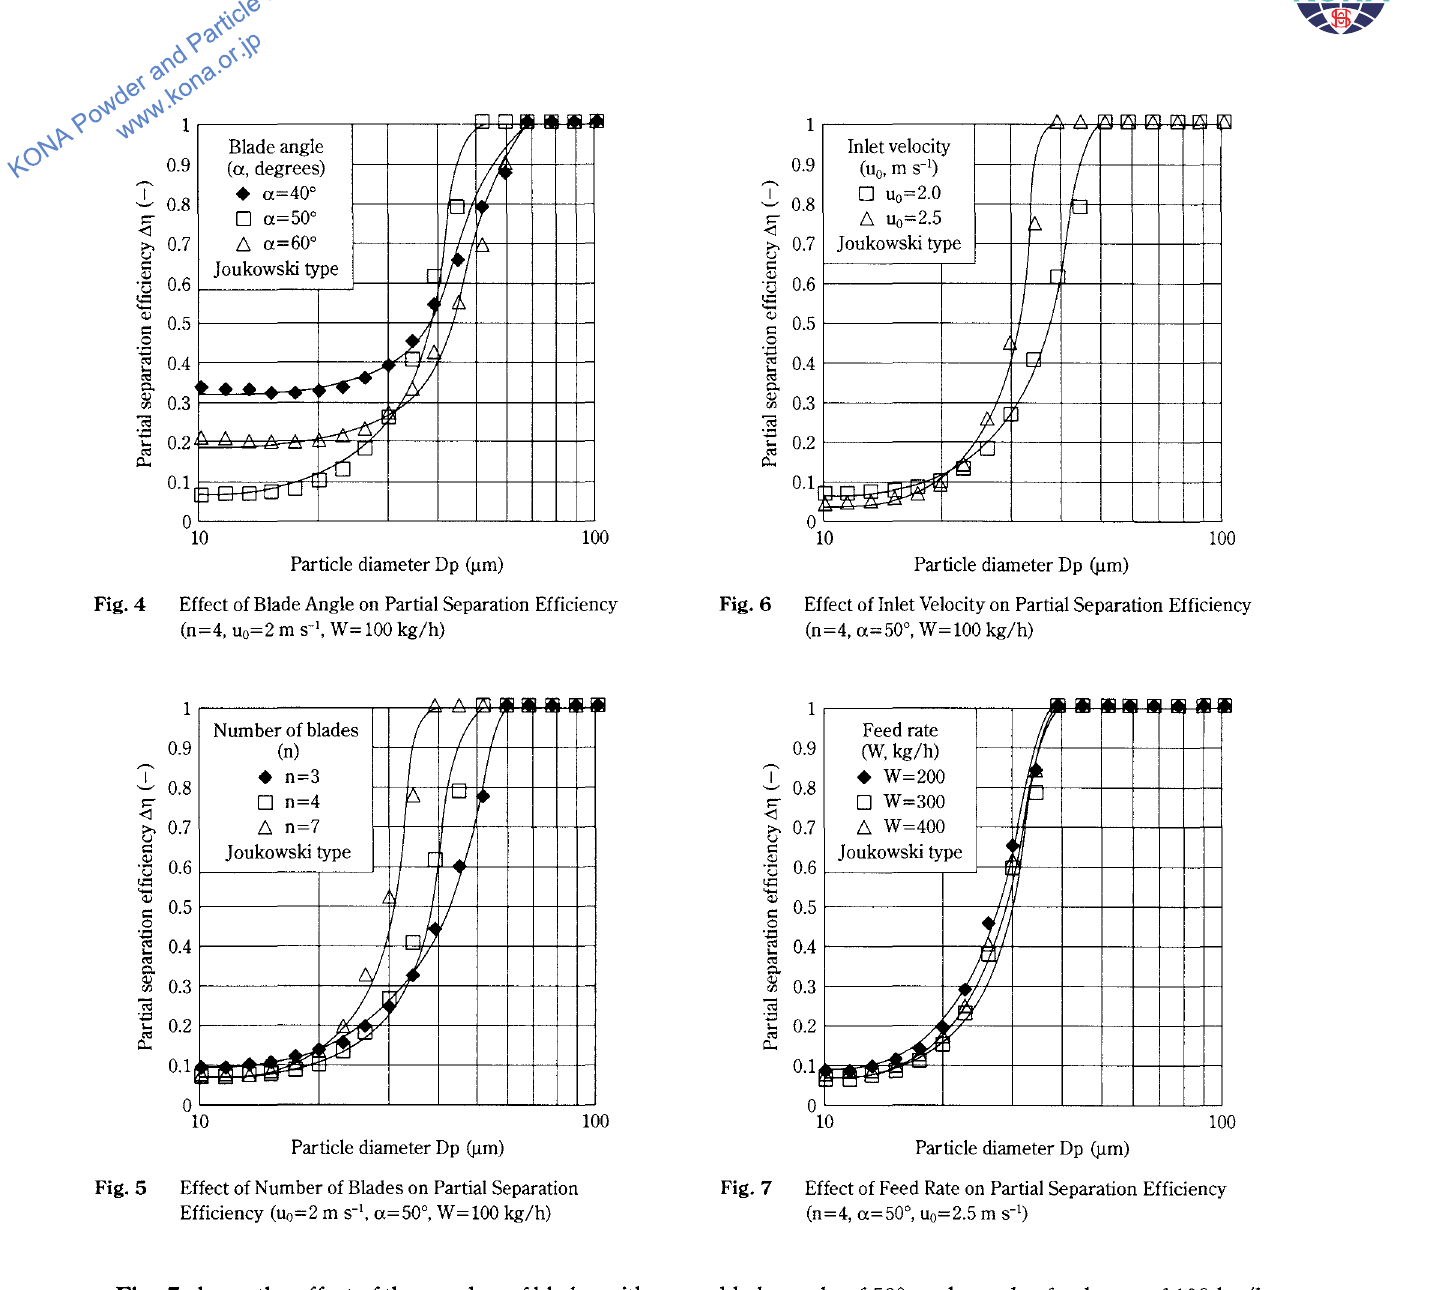
blade angle of 50°, and powder feed rate of 100 kg/h. For the inlet velocity equals to 2.5 m/s, the cut size becomes small compared to the 2 m s- 1 velocity, and better separation is realized. Because of a better dis persive effect on agglomerated particles among the louver blades and an increase in the inertial effect of particles, the classification performance becomes bet ter for inlet velocity equals to 2.5 m/s. Fig. 7 shows the effect of powder feed rate on separation performance. When using the Joukowski blades, the change in separation performance is small even when the powder feed rate increased from 200 to 400 kg/h. Hence the Joukowski blades used in this experiment are considered promising for practical